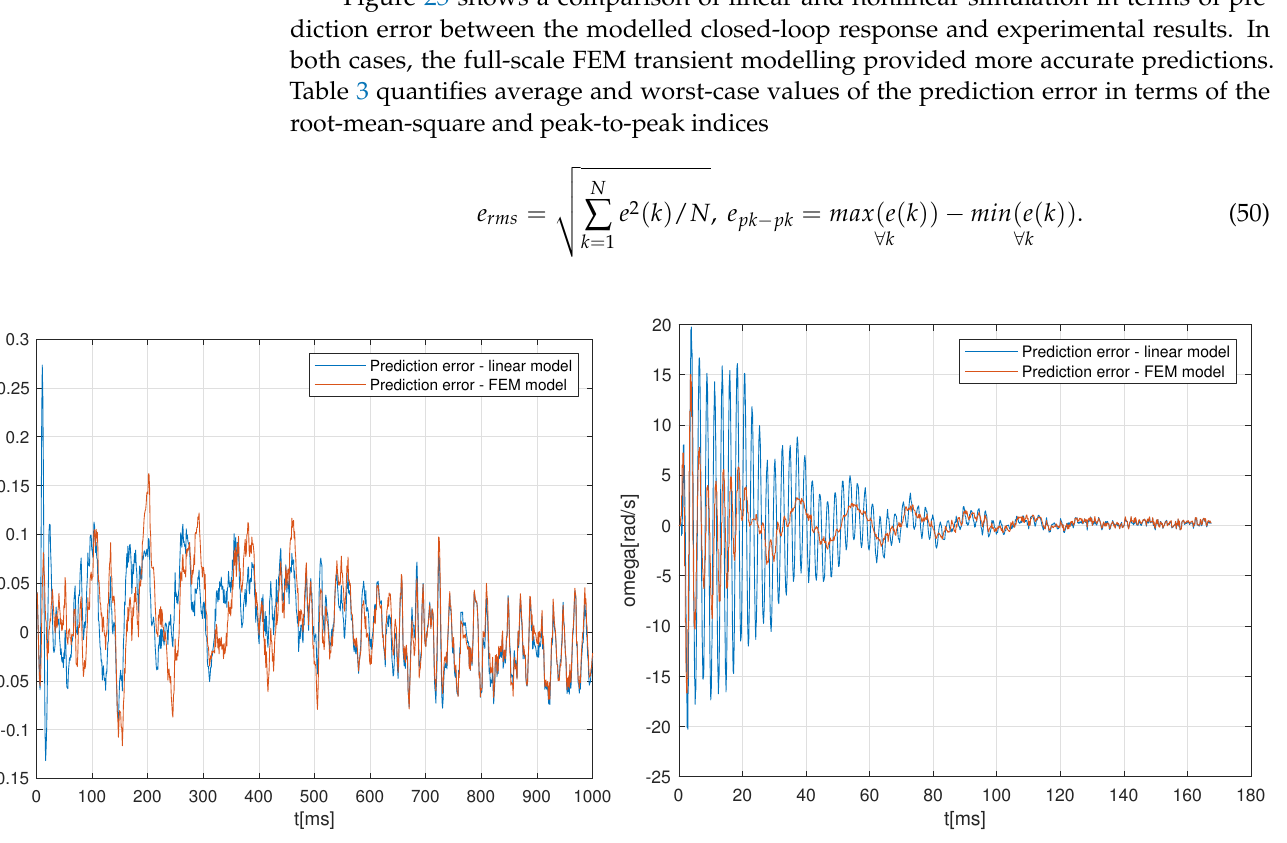
Figure 25. Comparison of reduced order linear simulation with full scale FEM model transient simulations: evolution of prediction error in the reference-following ( left ) and disturbance-rejection ( right )